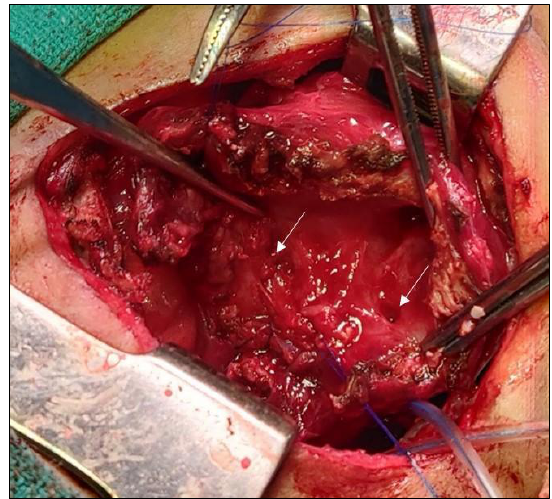
Figure 2: Intraoperative photograph after separating the esophagus from the lung parenchyma, and laying open the abscess cavity. Note multiple bronchi are communicating with the abscess cavity (arrows). After the mandated period of the home, quarantine was over, the patient was readmitted 2 weeks later with some weight gain. A contrast study was performed with oral contrast, which demonstrated leakage from anastomosis communicating with an abscess cavity probably in the right lower lobe (Fig. 1). After stabilization, he was explored again through